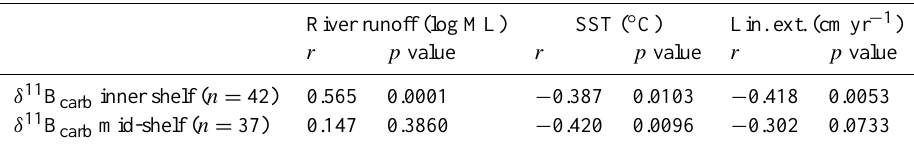
Table 3. Pearson correlation coefficients ( r ) and corresponding p values for correlations of annual composite coral δ 11 B carb records from the inner shelf (1964–2005) and mid-shelf (1973–2009) with Burdekin River runoff, SST from HadISST1, and coral linear extension rates for the corresponding region taken from D’Olivo et al.